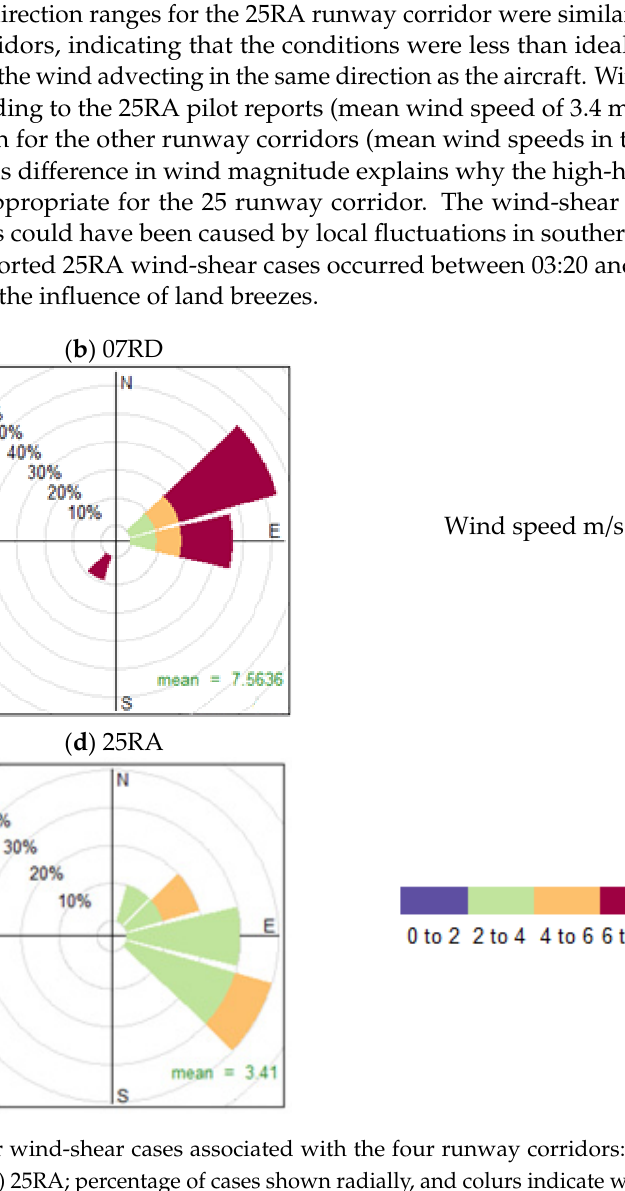
Table 6. Resultant wind-speed (m/s) thresholds calculated from the ROC-curve analysis. A quanti- tative indicator of performance is given in brackets for each scenario (with better performance indi- cated in bold, corresponding to POD × (1 − FAR) × (POD − FAR) > 0.2). Vertical